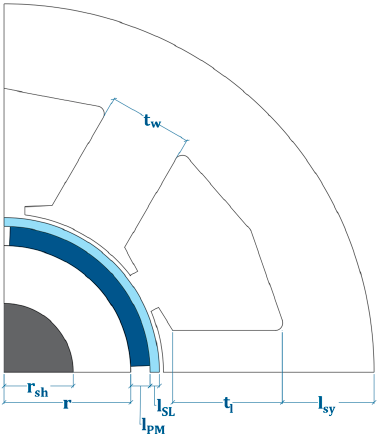
Figure 1. Definition of the main parameters of stator and rotor geometries.